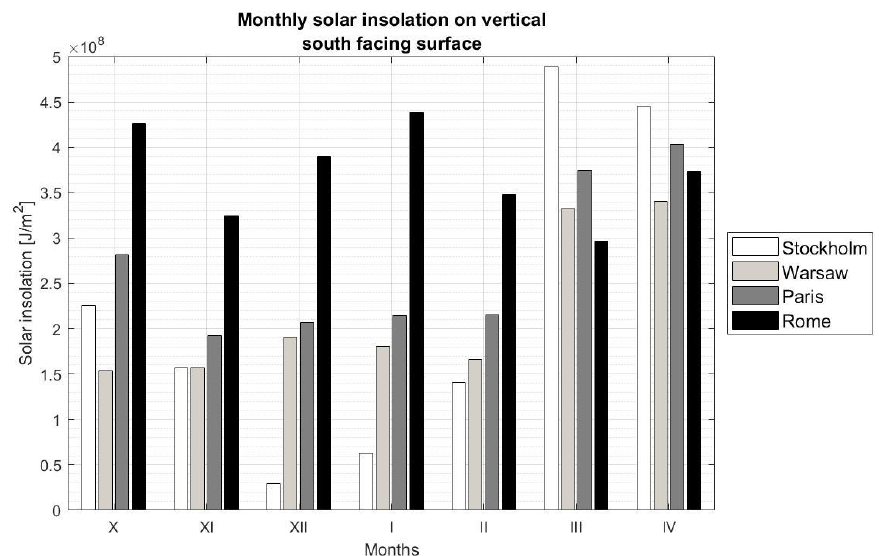
Figure 3. Monthly solar insolation on a vertical south facing flat surface during the heating period (calculated on the basis of data from [44]).